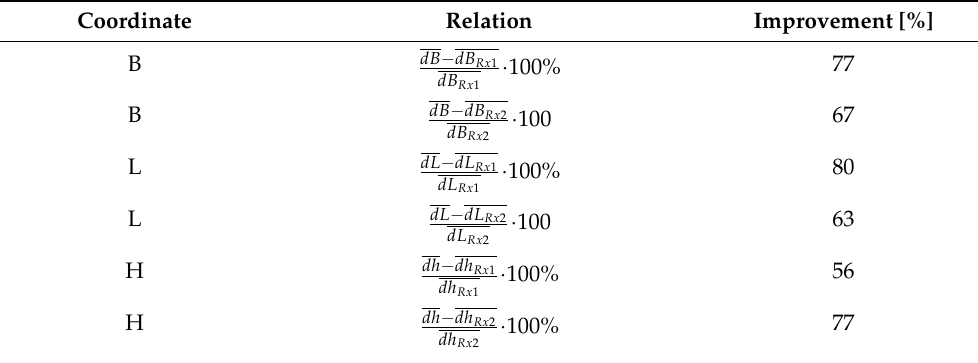
Table 1. Percentage change in resultant positioning accuracies relative to a single SDCM position error